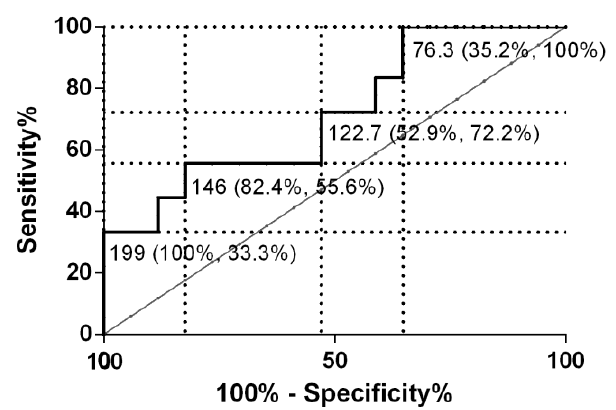
Figure 6. Receiver operating characteristic curves (ROC) of serum type III collagen for differentiation of fertile from infertile mares. Cut-off values are expressed in ng/mL (specificity, sensibility).